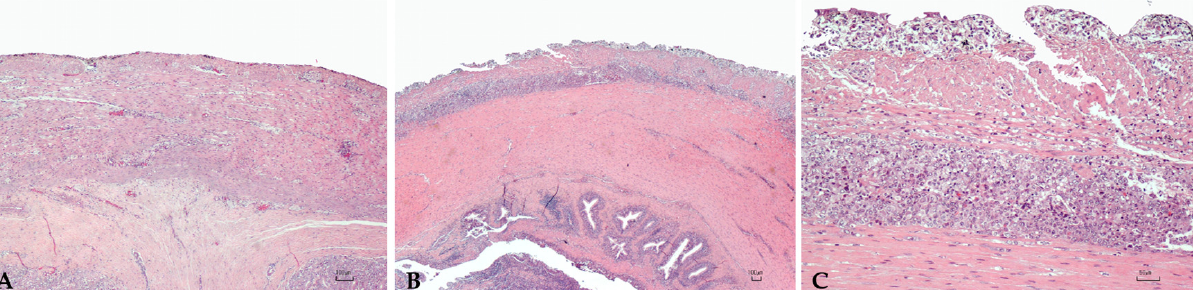
Figure 3. Intestine. Mild ( A ) and severe ( B , C ) granulomatous chronic enteritis. C: High magnifica- tion, B showing a high number of activated macrophages located in the serosa and the outer muscular layer. H.E. Bar A–C = 100 μ m. Table 2. Histopathology.